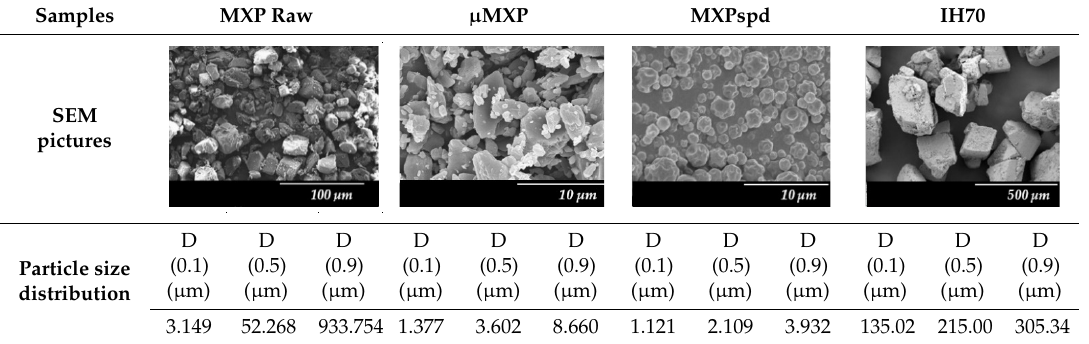
Table 2. Particle size distribution and morphology of the raw MXP, µMXP, MXPspd, and IH 70.